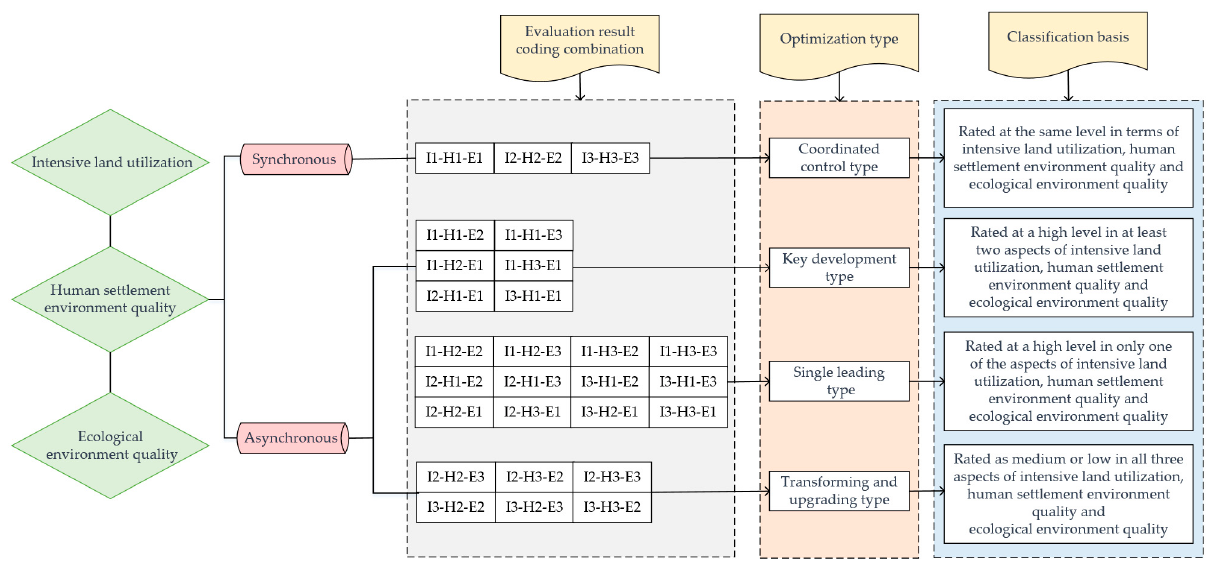
Figure 2. Classi fi cation of rural residential areas. Figure 2. Classification of rural residential